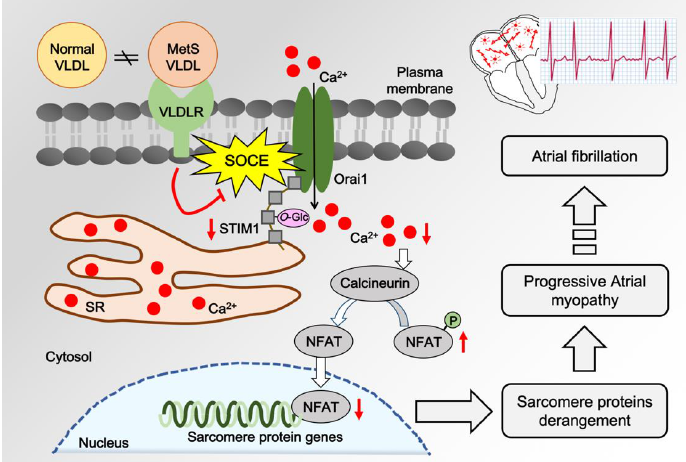
Figure 5. Lipotoxicity of VLDLs on mediating maladaptation of calcium regulation to derangement of sarcomere proteins in atrial myopathy. In metabolic syndrome (MetS), VLDLs undergo biochemical property changes and become different from VLDLs of normal conditions [23]. MetS-VLDLs reduce STIM1 expression and enhance O -GlcNAcylation on STIM1 protein. These changes in concert suppress SOCE and the downstream calcineurin – NFAT pathway, resulting in alteration of myofilament protein expression, disruption of sarcomere organization, and atrial myopathy [35]. The progression of atrial myopathy ultimately leads to atrial